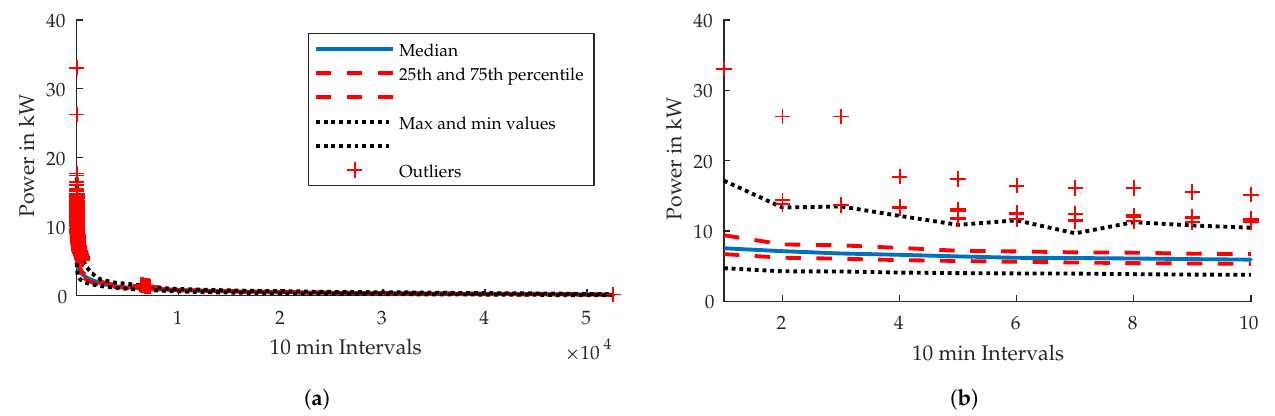
Figure 9. ( a ) Load duration curve based on 10-min averages. ( b ) Zoomed version of ( a ).